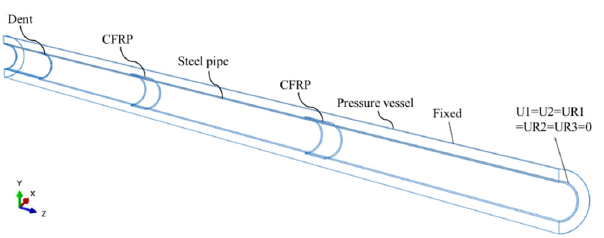
Figure 6. Schematic diagram of the boundary conditions of the pipeline model.